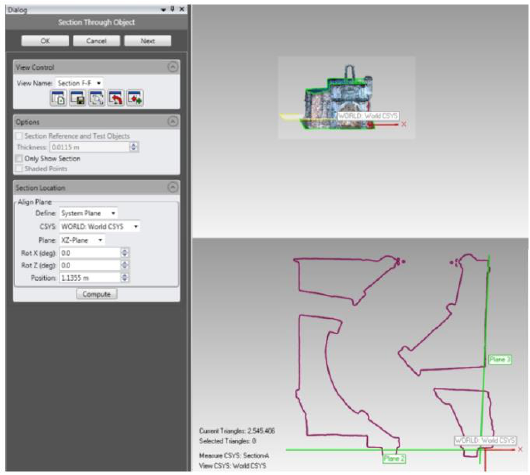
Figure 5. Creating a section plane through System Plane